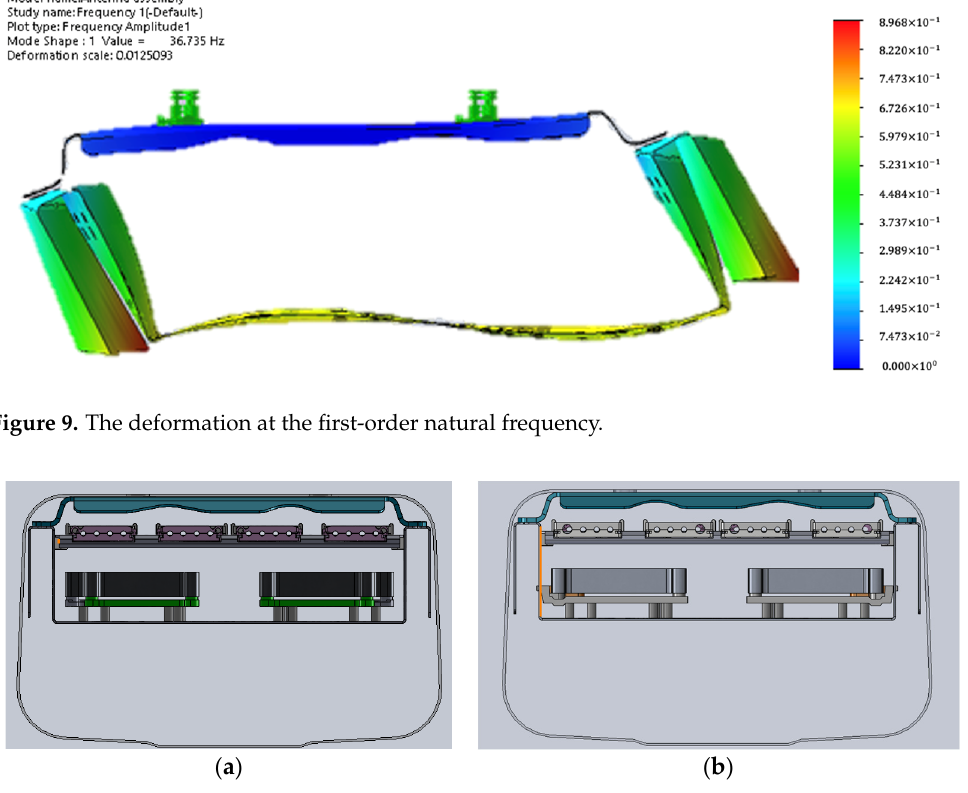
Figure 10. A new design to enhance the reflector: ( a ) the section view of the original design; ( b ) the section view of the improved design. Table 1. Comparison result list between original design and improved design.